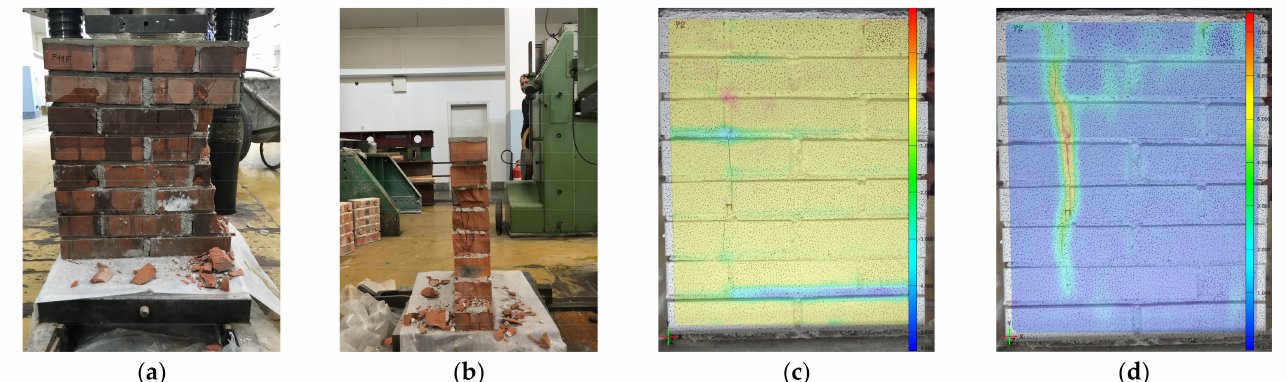
Figure 1. Testing of compressive strength—vertical splitting of masonry prism: ( a ) front view; ( b ) side view; ( c ) vertical deformations; ( d ) horizontal deformations.